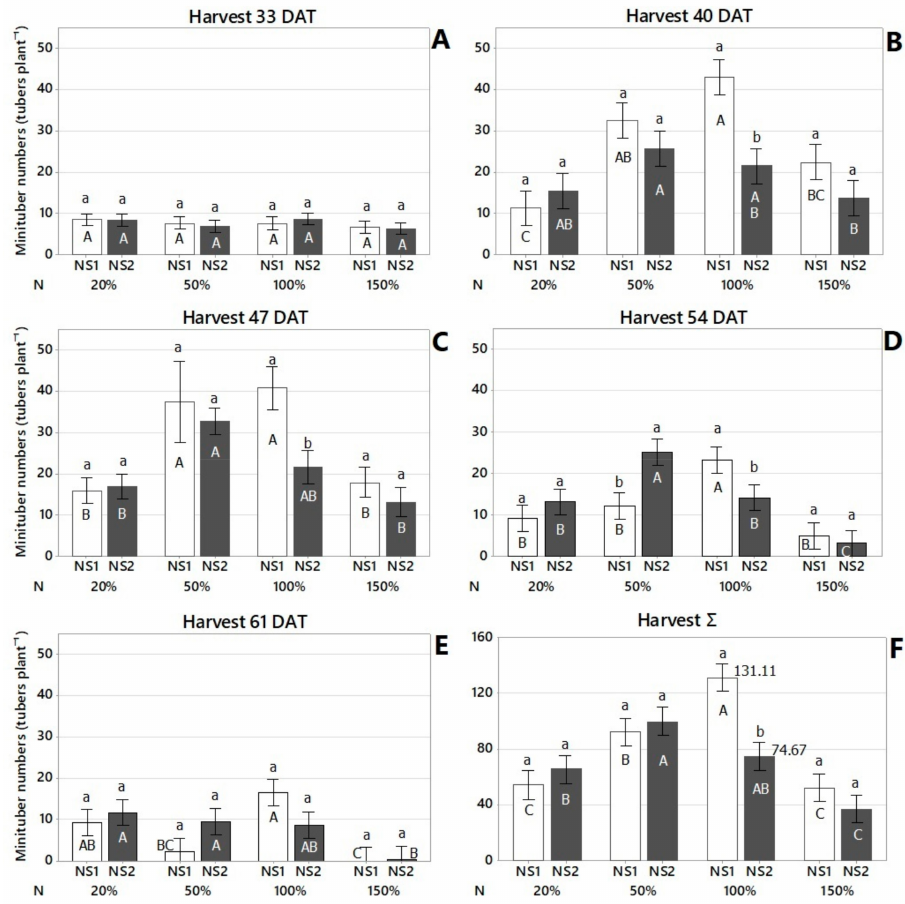
Figure 3. Effect of nutrient solution (NS) and nitrogen (N) concentration on minituber yield at 33 ( A ), 40 ( B ), 47 ( C ), 54 ( D ), 61 days after transplant—DAT ( E ), and total harvest ( F ). Lowercase letters indicate statistically different nutrient solutions (NS) within each nitrogen concentration (N) for each harvest time, according to Fisher’s LSD test ( p < 0.05). Uppercase letters indicate statistically different nitrogen concentrations (N) within each nutrient solution (NS), for each harvest time, according to Fisher’s LSD test ( p < 0.05). Interval bars represent standard errors ( n = 9). NS1: Otaz ú ’s nutrient solution and NS2: modified Furlani’s nutrient solution. N: nitrogen concentration of the crop-recommended dose to produce seed